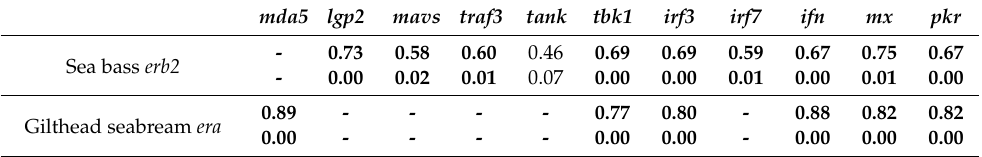
Table 3. Correlations observed between the gene expression of erb2 in European sea bass or era in gilthead seabream testis and interferon (IFN)-related genes after in vivo infection with NNV. The first line corresponds to the Pearson coefficient of correlation and the second to the p value. Written in bold are the correlated parameters. mda5 , melanoma differentiation-associated gene 5; lgp2 , laboratory of genetics and physiology 2; mavs , mitochondrial antiviral signaling; traf3 , tumor necrosis factor (TNF) receptor-associated factor 3; tank , TRAF3, family member-associated NF-kB activator 3; tbk1 , TANK-binding kinase 1; irf , IFN regulatory factor; mx , myxovirus (influenza) resistance protein; pkr , dsRNA-dependent protein kinase receptor; er , estrogen receptor.